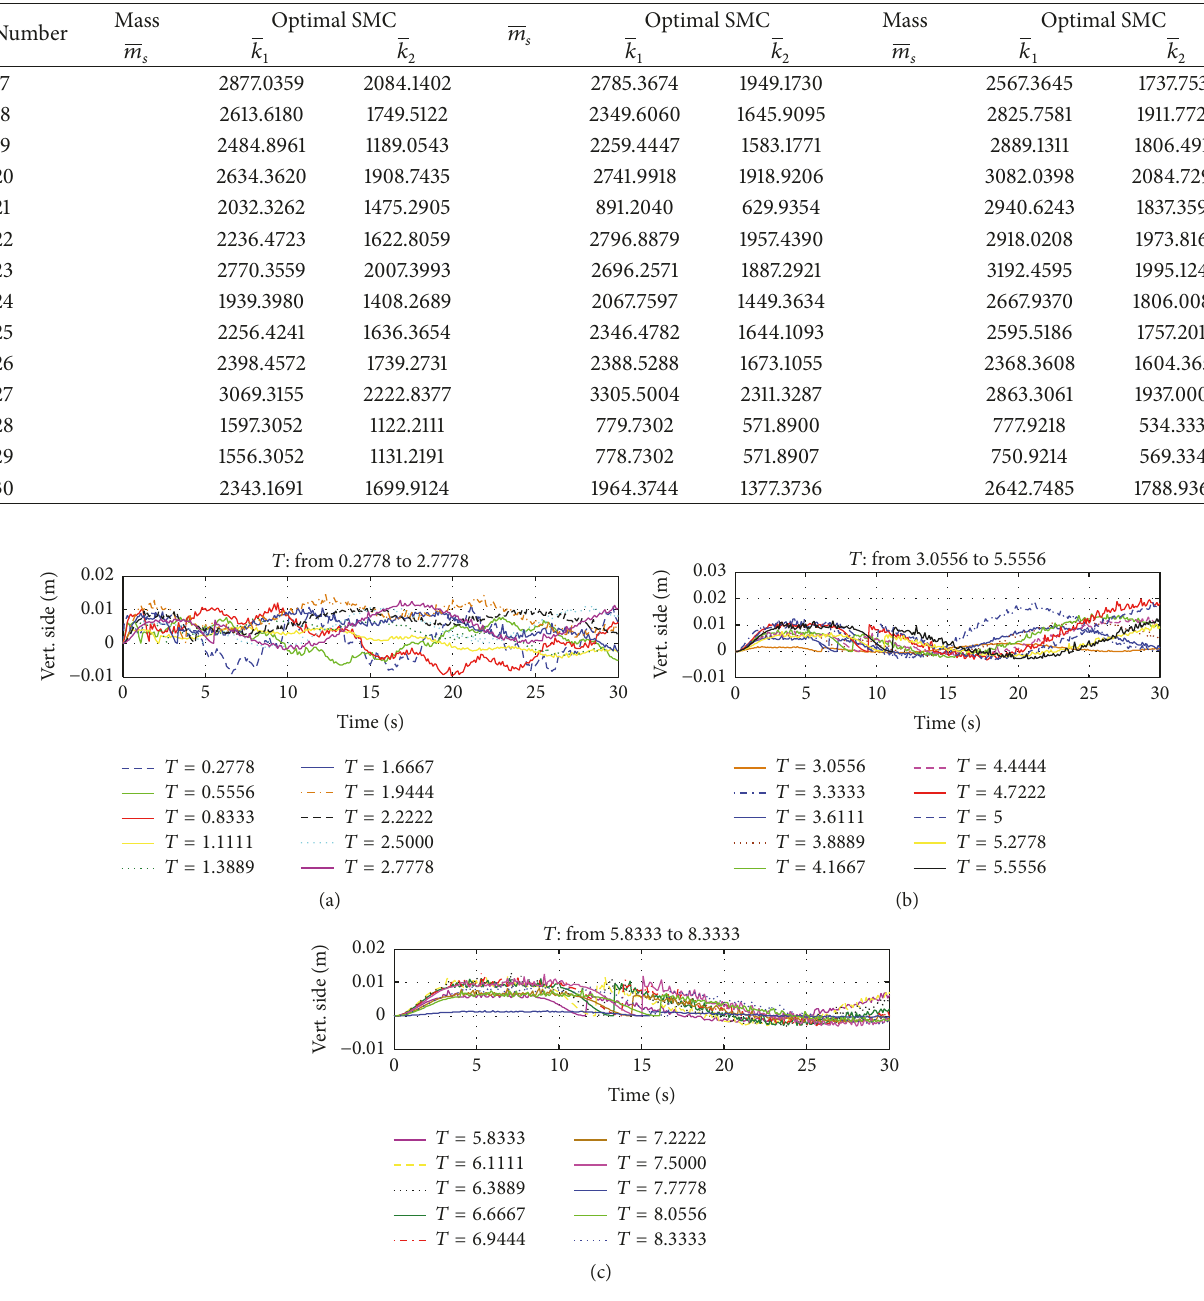
Figure 7: Track profiles are used to build the dataset for establishing the T2F-SMC-TPM in which 𝑇 is adjusted from 0.2778 to 2.7778 second (a), 3.0556 to 5.5556 second (b), and 5.8333 to 8.3333 second